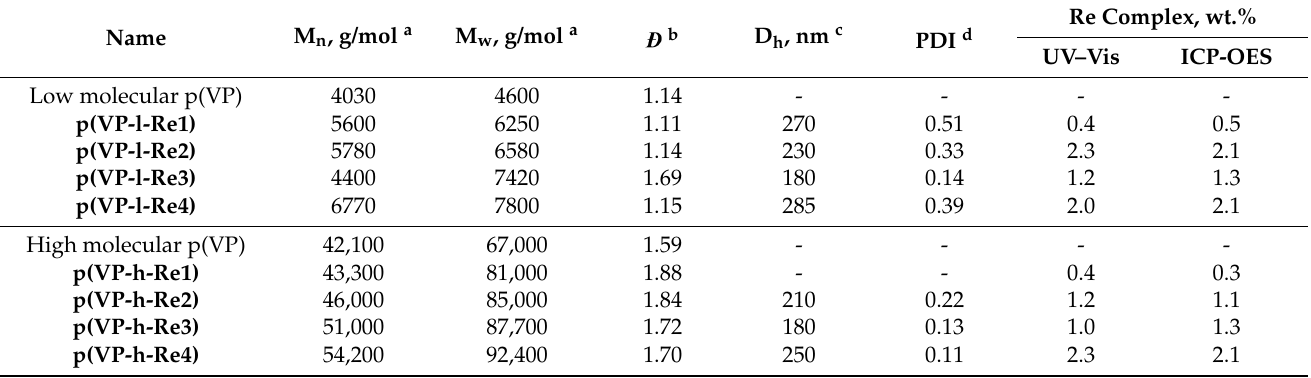
Table 1. The molecular weight characteristics of the p(VP-l/h-Re) polymers, particle sizes of the p(VP-l/h-Re) polymers, and values of the Re(I) complex loading into the p(VP-l/h-Re) obtained via UV–Vis spectroscopy and